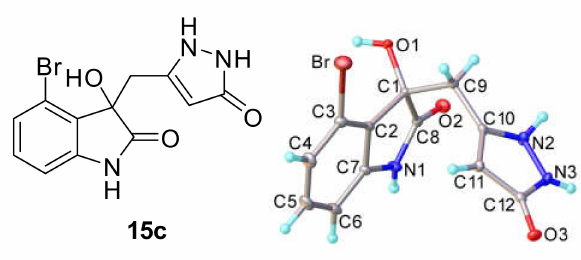
Figure 3. X-ray structure of the compound 15c where the pyrazole is in its keto form.